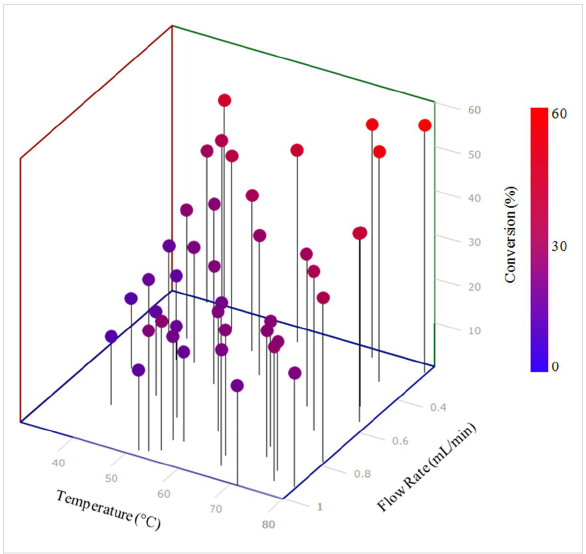
Figure 8: Optimisation plot for the SIMPLEX optimisation of semicar- bazone 1 . Optimum reaction conditions were found to be a flow rate of 0.24 mL/min and a temperature of 79.6